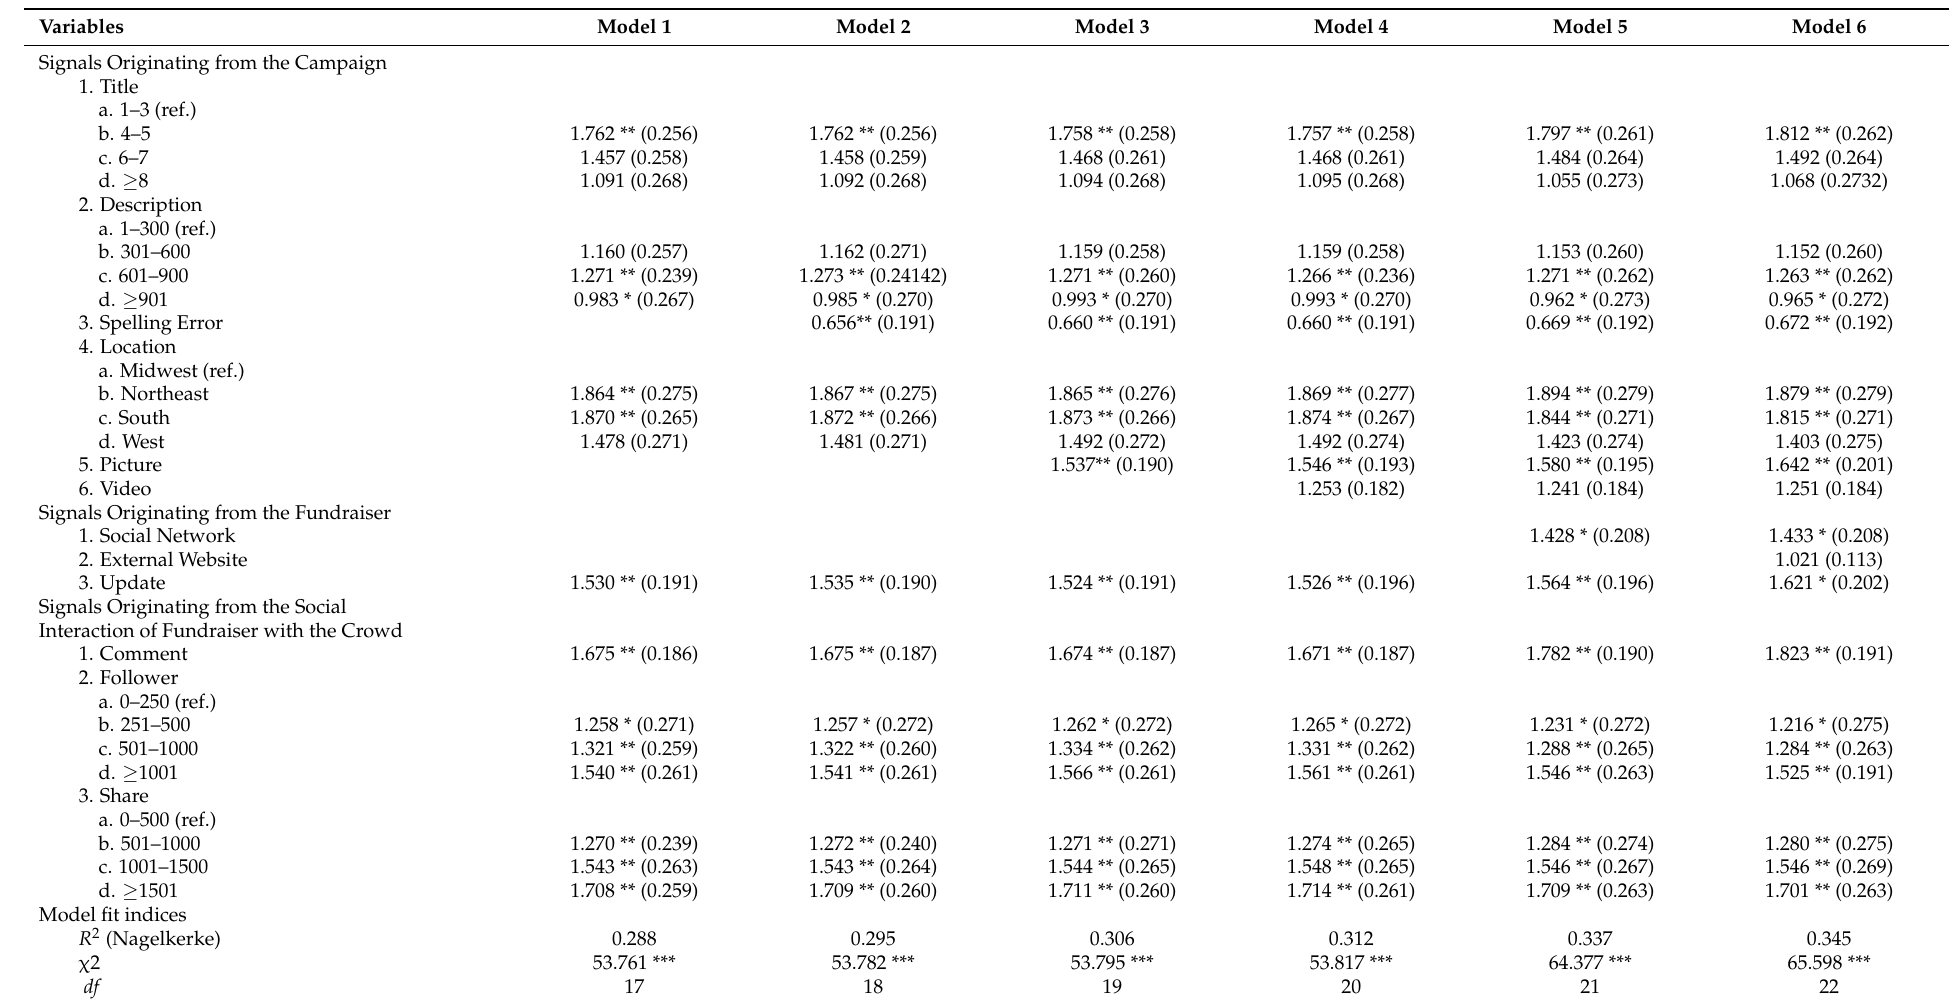
Table 5. Results of logistic regression